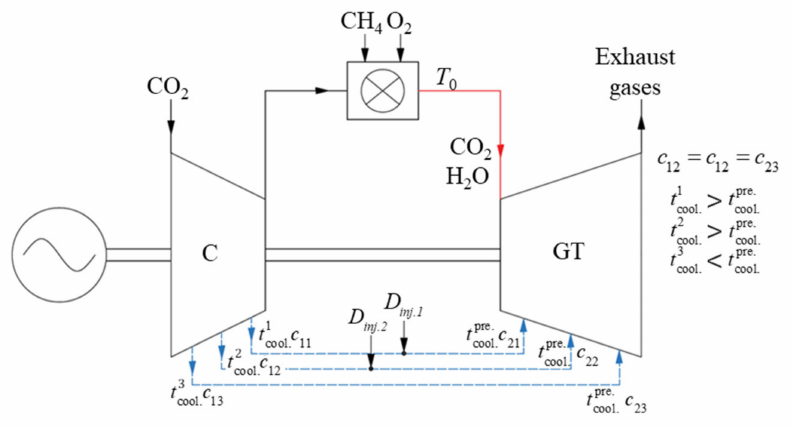
Figure 9. The SCOC-CC cycle coolant preliminary cooling water injection preliminary cooling.